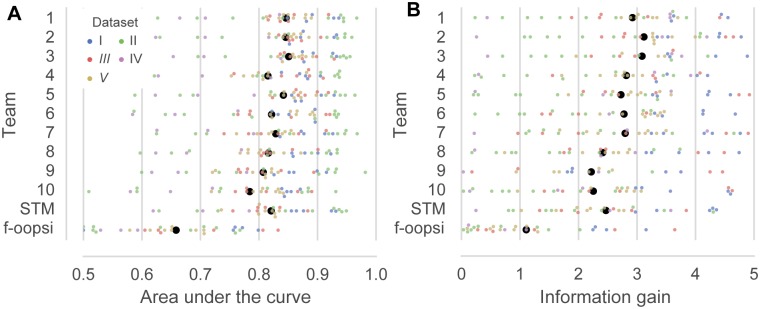
Different spike inference metrics reach similar conclusions.A. Area under the curve (AUC) of the inferred spike rate used as a binary predictor for the presence of spikes (evaluated at 25 Hz, 50 ms bins) on the test set. Colors indicate different datasets. Black dots are mean correlation coefficients across all N = 32 cells in the test set. Colored dots are jittered for better visibility. STM: Spike-triggered mixture model [15]; f-oopsi: fast non-negative deconvolution [9] B. Information gain of the inferred spike rate about the true spike rate on the test set (evaluated at 25 Hz, 40 ms bins).